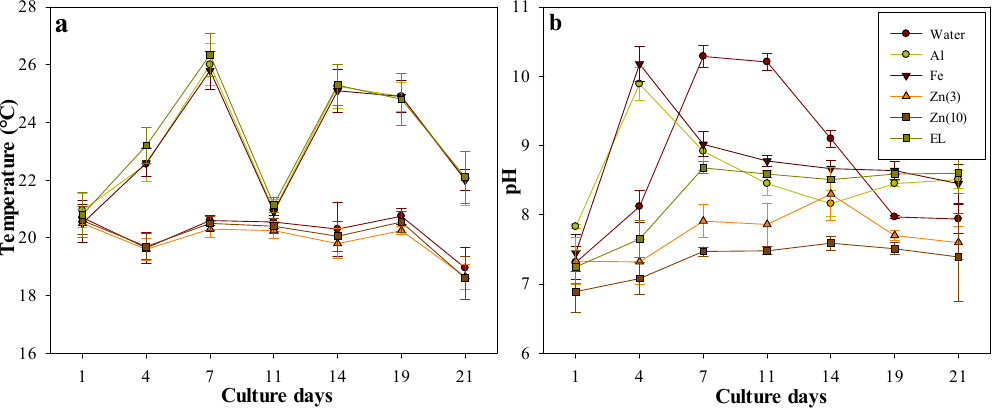
Figure 2. Variations in mean temperature and pH (±S.D.) of water in the different treatments over a period of 21 days ( a is temperature, b is pH).